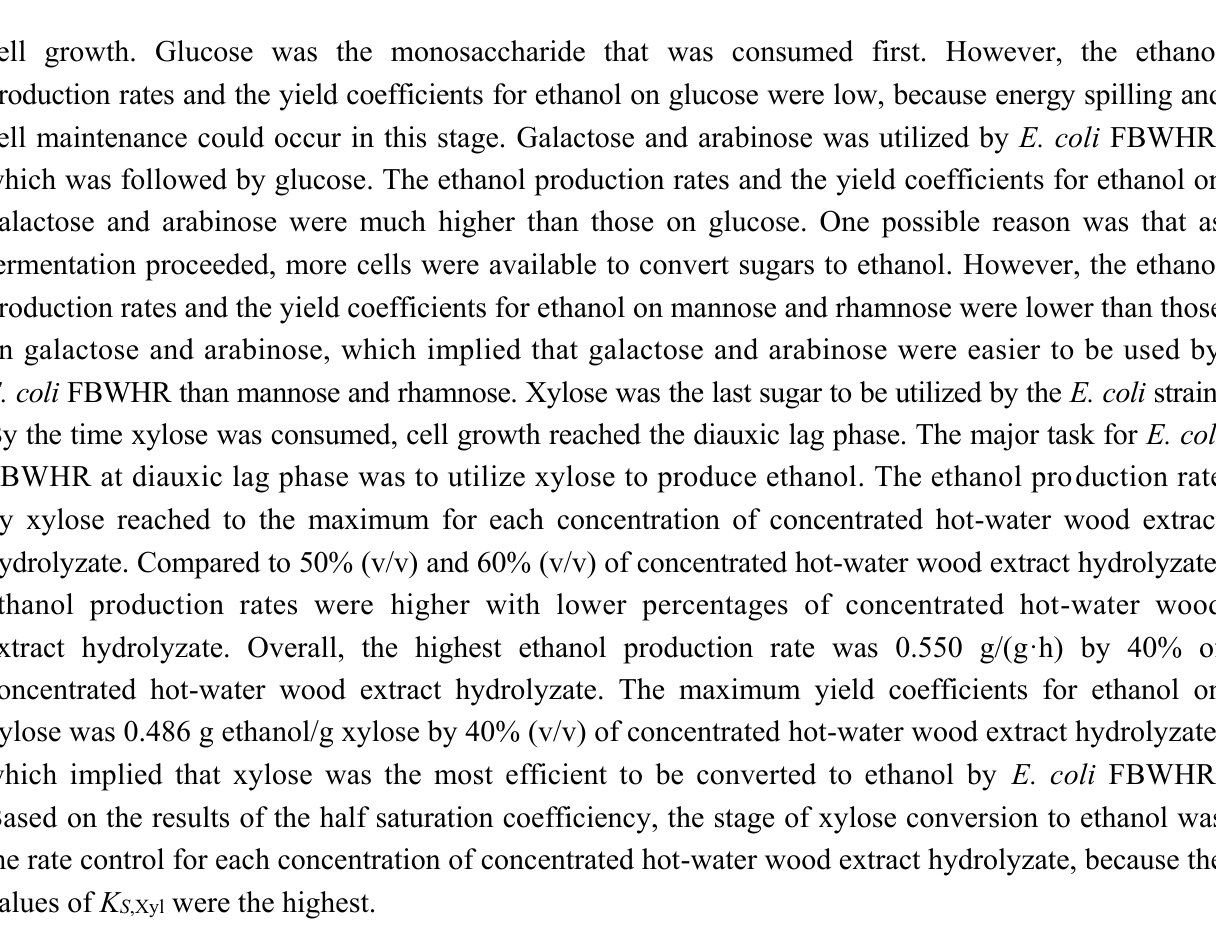
Table 2. Model parameters of ethanol production by fermentation with recombinant E. coli FBWHR using different concentrations of concentrated hot-water wood extract